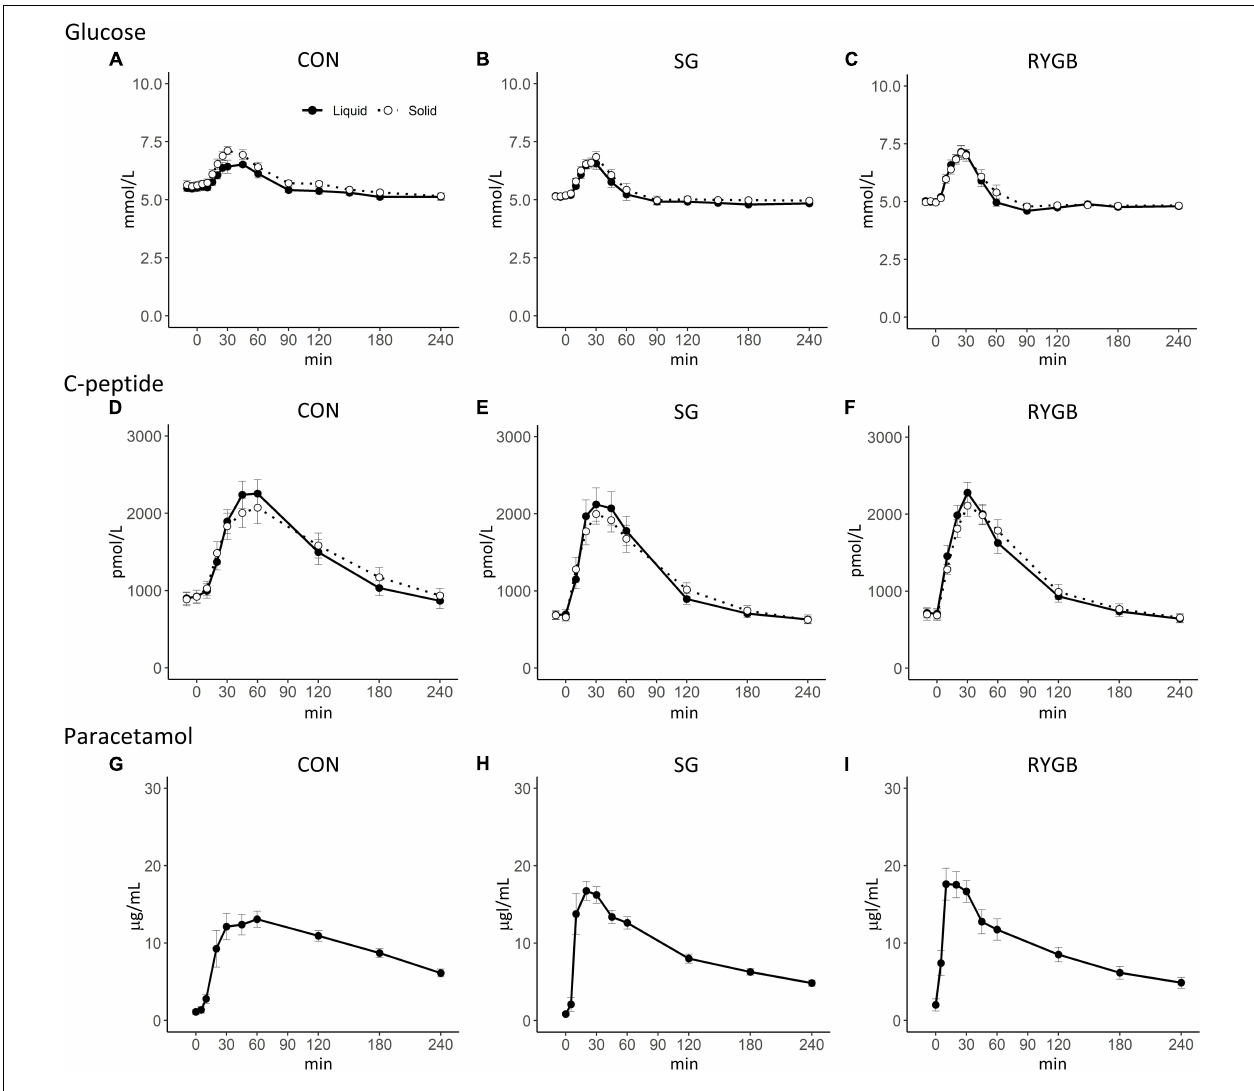
FIGURE 1 | Plasma concentrations of plasma glucose and C-peptide on two different study days with either a liquid or a solid meal. Plasma concentration of and paracetamol was studied after a liquid meal. (A–C) Plasma glucose (D–F) C-peptide (G–I) Paracetamol. Data are means ± SEM. Black (solid line): liquid; white (dotted line):